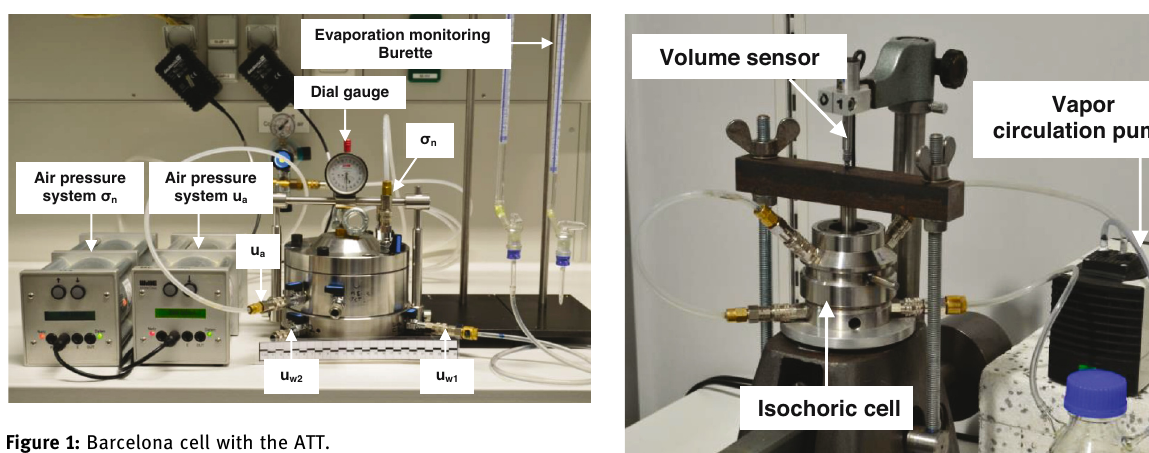
Figure 1: Barcelona cell with the ATT.